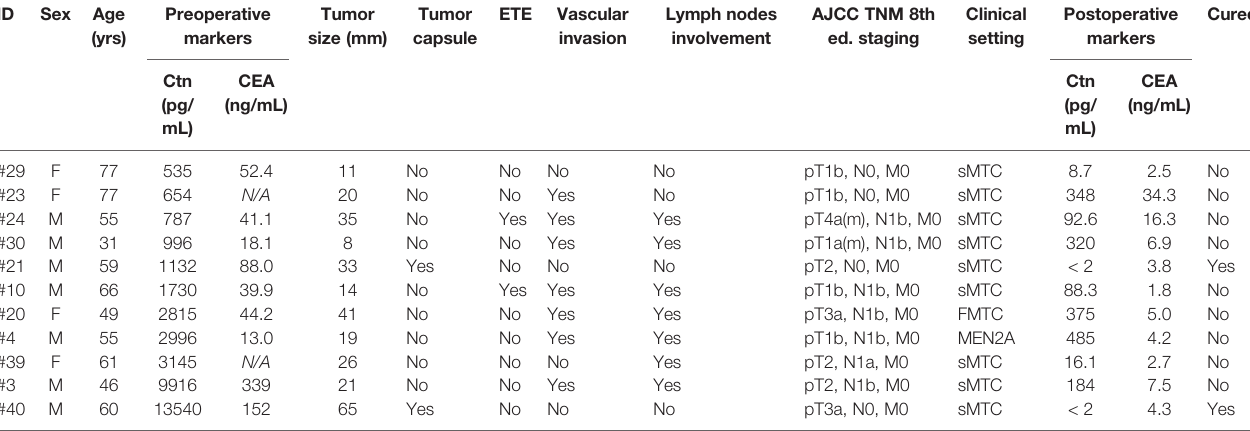
TABLE 3 | Clinical and histopathological characteristics and response to surgery of MTCs presenting with preoperative serum Ctn levels above 500 pg/mL. ID Sex Age Preoperative (yrs) markers